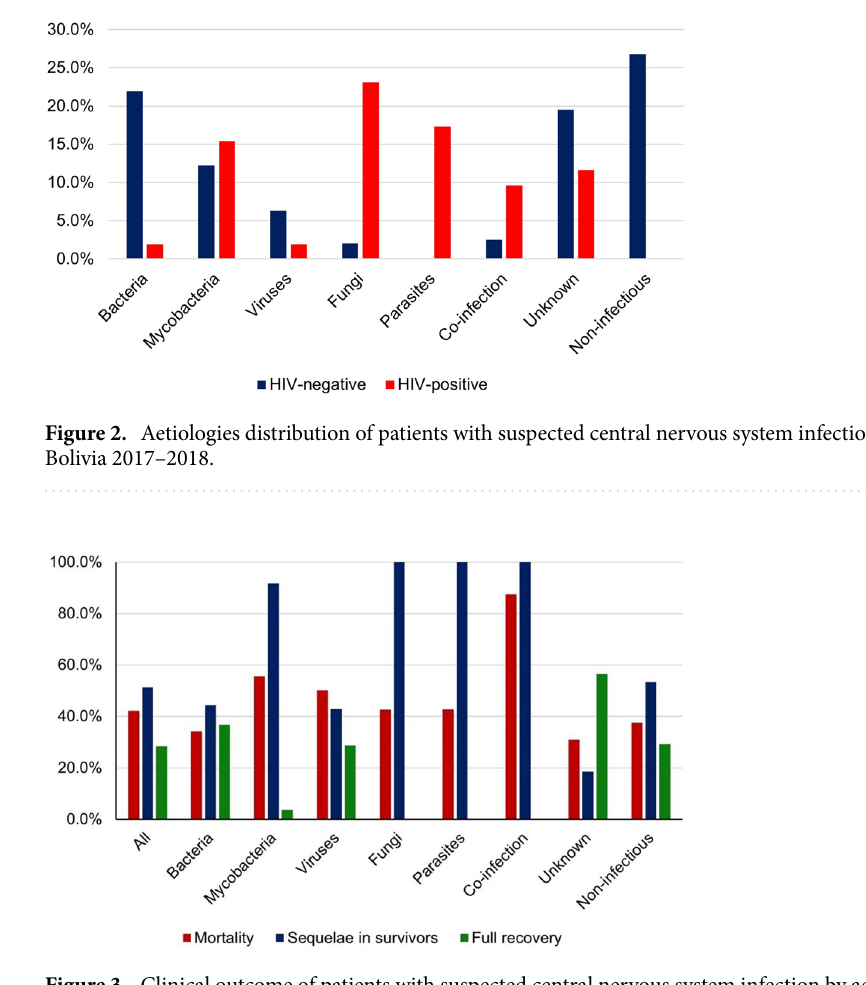
Figure 3. Clinical outcome of patients with suspected central nervous system infection by aetiology. Bolivia